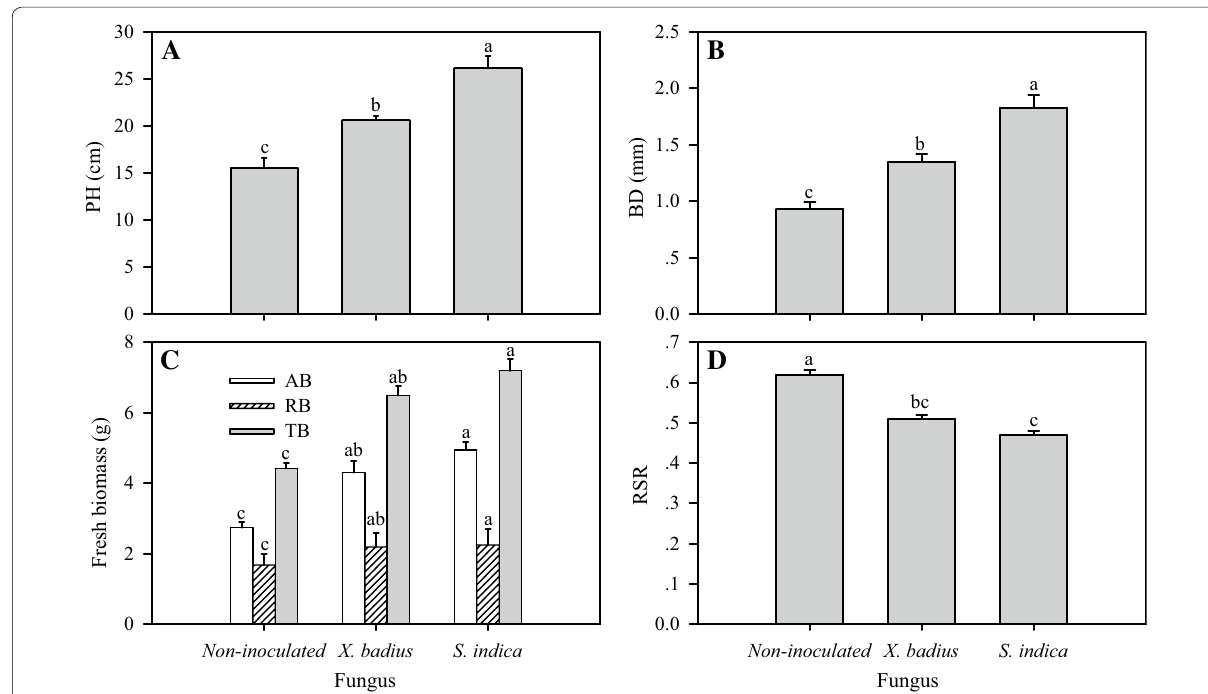
Fig. 4 Effect of X. badius and S. indica inoculation on PH ( A ), BD ( B ), fresh biomass ( C ) and RSR ( D ) of L. multiflorum seedlings. AB above-ground biomass, BD basal diameter, PH plant height, RB root biomass, RSR root/shoot ratio, TB total biomass. Values are means of six replicates. Bars represent the standard deviation. Lowercases show statistically significant differences for the same parameter among L. multiflorum seedlings inoculated by X. badius and S. indic a at P 0.05 based on Tukey’s HSD post hoc ≤